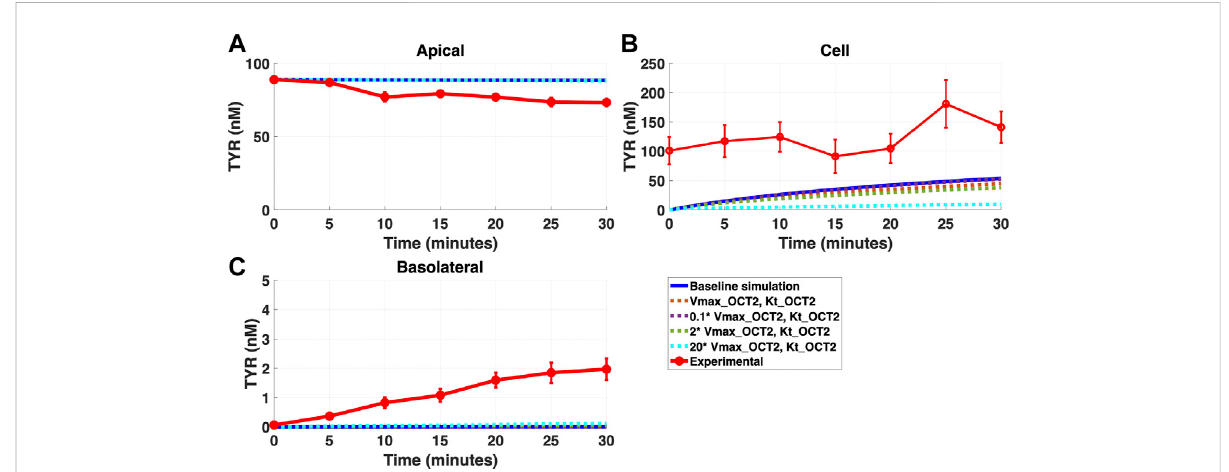
FIGURE 5 Introduction of OCT2 at variable densities to the Caco-2 basolateral membrane worsens model accuracy following apical TYR loading. The transport of 88.9 nM TYR across Caco-2 cells was modeled following basolateral loading by solving Eqs 4 – 8, using the values mentioned in Supplementary Table S2, using MATLAB vR 2021a. Comparisons were made between the models (baseline = blue curve; modi fi ed = dotted curves) for the apical Panel 5 (A) , cellular Panel 5 (B) and basolateral compartments Panel 5 (C) , versus experimental observations; red curve (Sarkar and Berry, 2020). Addition of an OCT2-like transporter to the basolateral membrane at varying densities either had no effect, or worsened, modelling of TYR concentration-time pro fi les. Some of the curves have overlapped except experimental curve. Kinetic parameters used for this modelling were: